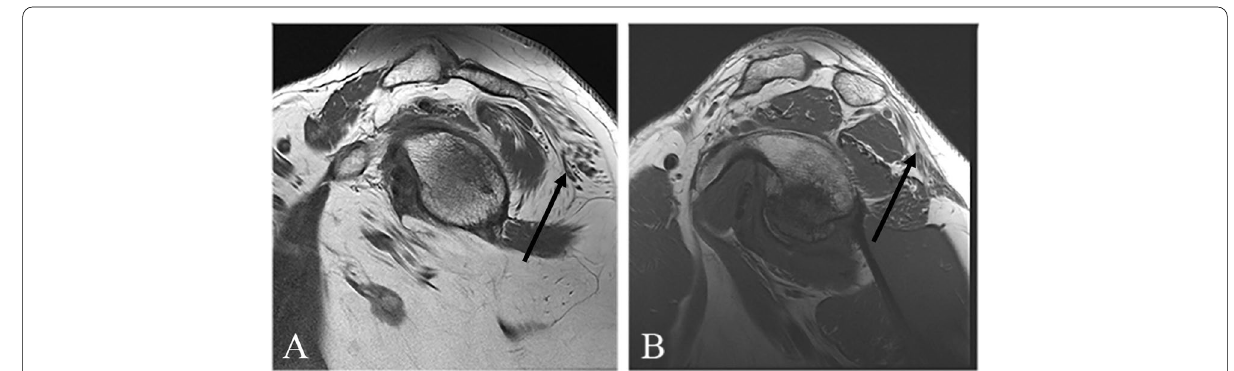
Fig. 2 Sagittal T1‑weighted MRI demonstrating fatty infiltration of the deltoid muscle in 2